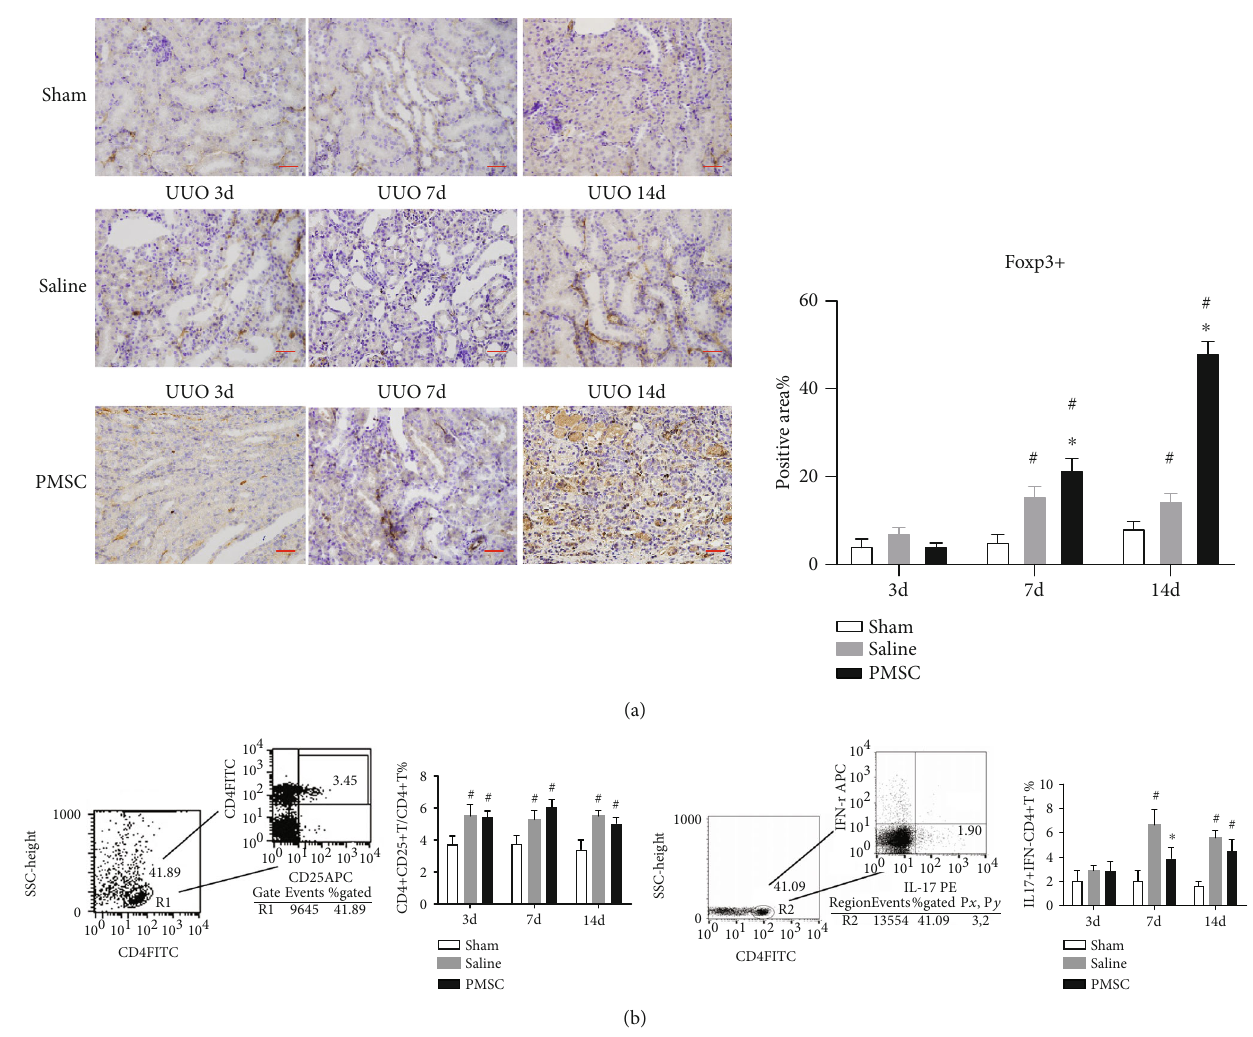
Figure 3: E ff ects of PMSCs injection on regulating CD4 + CD25 + Foxp3 T cells and IL17 + IFN - T cells of UUO rats in vivo. (a) IHC staining of Foxp3 in kidney sections from Sham, Saline, and PMSC group at days 3, 7, and 14 after UUO, respectively. Representative pictures are acquired. Scale bar: 50 μ m. Foxp3 positive percentage was quantitated by measuring positive area from representative images and analyzed by image J software. ∗ P < 0 : 05 compared with Saline group; ∗ P < 0 : 01 compared with Saline group; # P < 0 : 05 compared with Sham group. (b) The percentage of CD4 + CD25 + T cells in CD4 + T cells extracted from PMNCs as well as the percentage of IL-17 + IFN - γ T cell in CD4 + T cells extracted from rat spleen homogenate was analyzed by FACs, respectively. # indicates P < 0 : 05 VS. sham. ∗ P < 0 : 05 compared with Saline group; # P < 0 : 05 compared with Sham